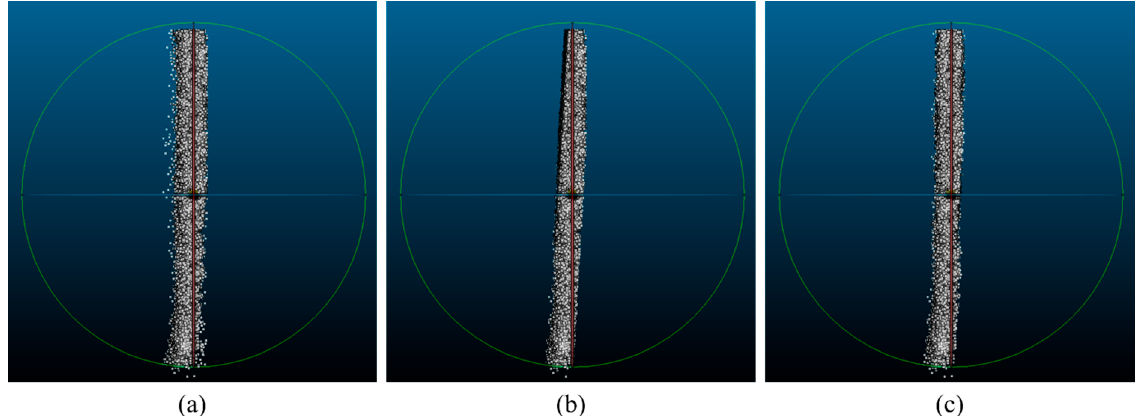
Figure 9. ( a ) Inputted PCD; ( b ) RANSAC on entire PCD; ( c ) RANSAC on voxels.